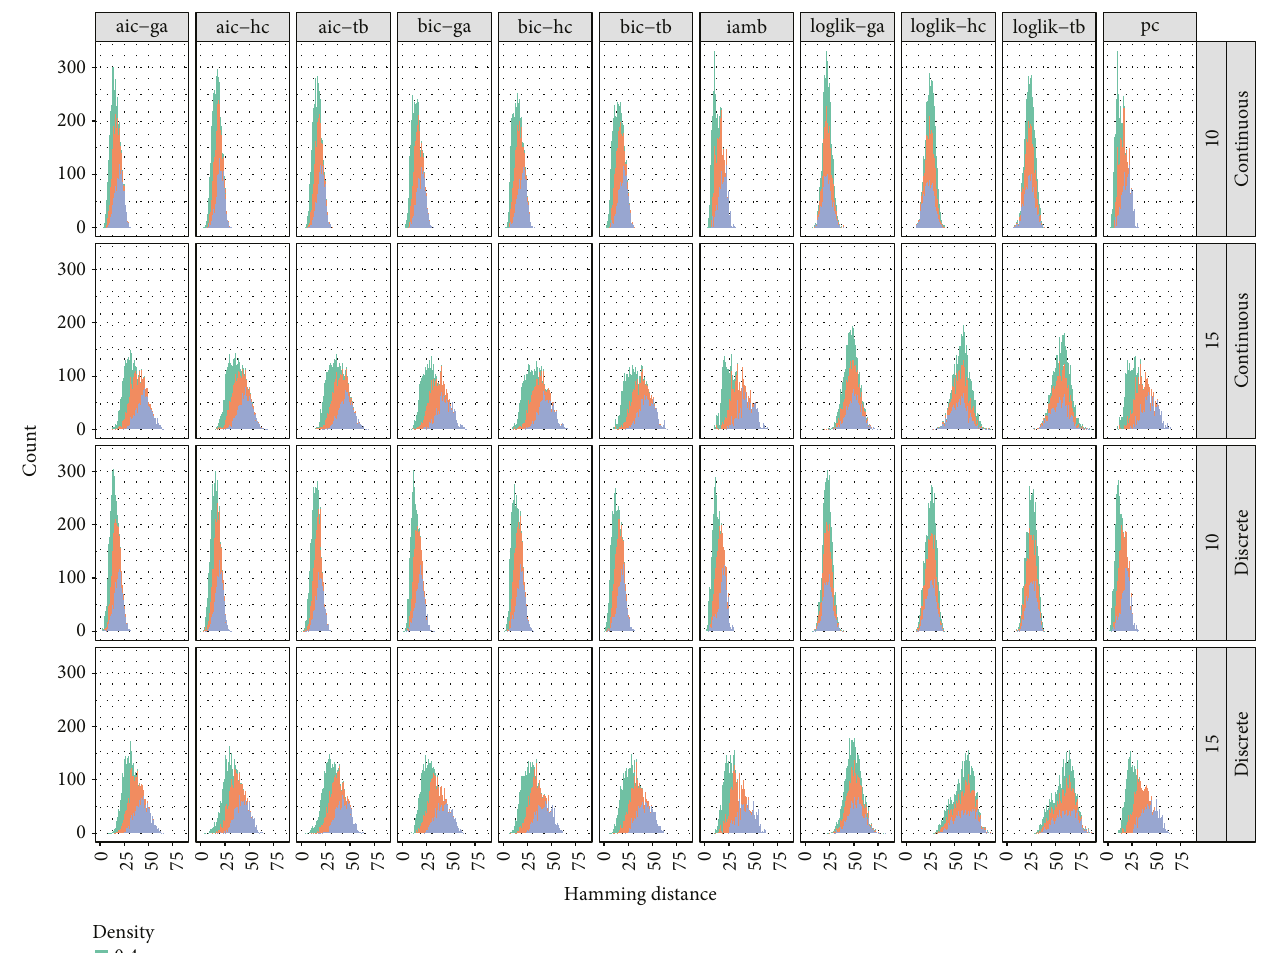
Figure 3: Bar plots showing the Hamming distances of the solutions obtained by the 11 tested approaches, grouped by type of dataset (discrete and continuous) and number of nodes of the network (10 and 15), while colors represent densities (0.4, 0.6, and